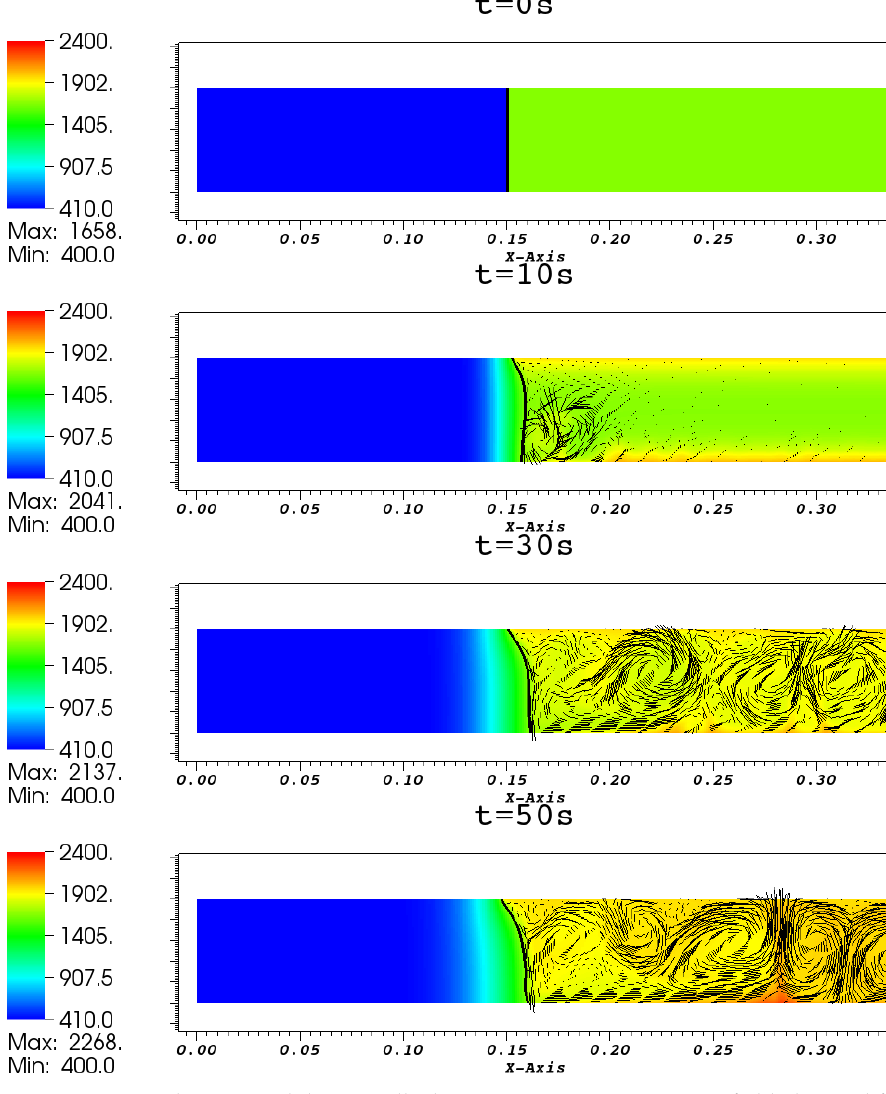
Figure 11. Two-dimensional thin metallic layer test case—Temperature field obtained for the thin metal layer and the vessel for different intermediate times t ∈ { 0,10,30,50 } s—Temperature in colors, velocity as thin black lines, interface as a thick black